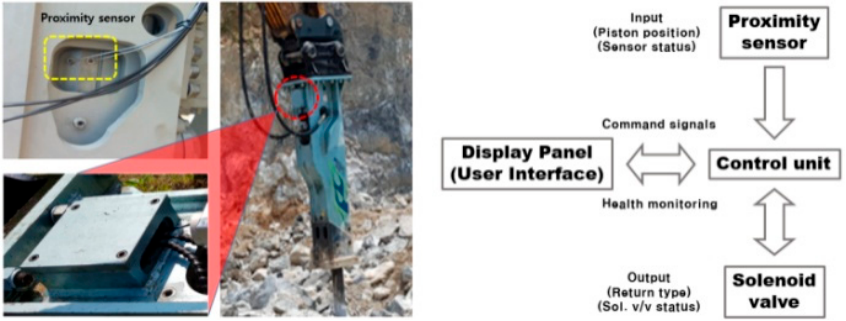
Figure 6. System of the hydraulic breaker.